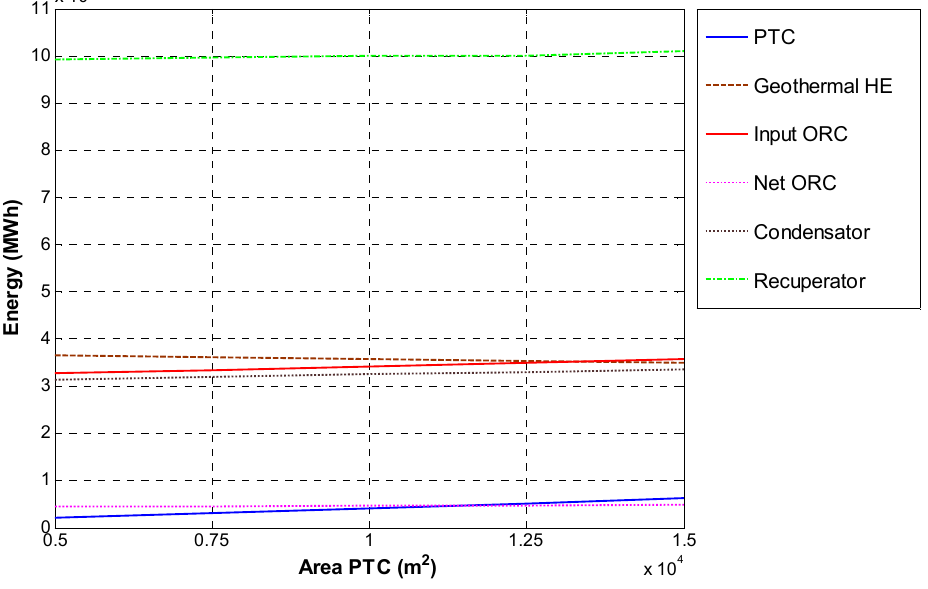
Figure 14. Thermal energy used and net electricity produced in a year varying collectors